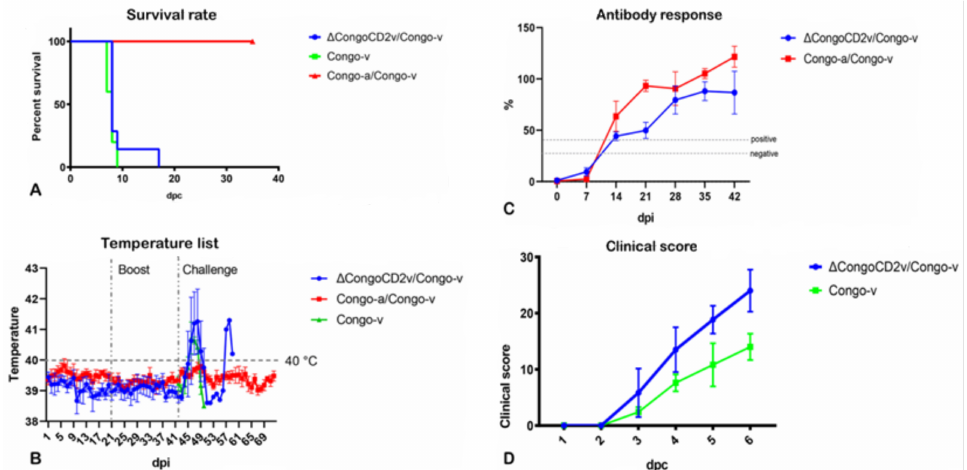
Figure 3. Kinetics of lethality ( A ) and body temperature ( B ) in pigs inoculated with ASFV strain Congo-a, strain ∆ CongoCD2v, and in mock-vaccinated pigs. The medium-dashed line represents the fever-cutoff (40 ◦ C) ( B ). Anti-ASFV antibody responses ( C ) measured using ELISA in pigs immunized with ASFV strain ∆ CongoCD2v and strain Congo-a at 0–42 dpi (cut-off 40%). Clinical scores ( D ) in pigs immunized with ASFV strain ∆ CongoCD2v and in mock-vaccinated pigs following challenge with virulent ASFV Congo-v at 0–6 dpc. Pigs were immunized with Congo-a (strain KK-262) (red line) or ∆ CongoCD2v recombinant virus (blue line), mock-vaccinated pigs (green line). Animals were challenged with virulent Congo-v (strain K-49). The data of body temperature, anti-ASFV antibody response, and clinical score are shown as average values and their SD in each of the groups. Analysis was conducted using Graphpad Prism software version